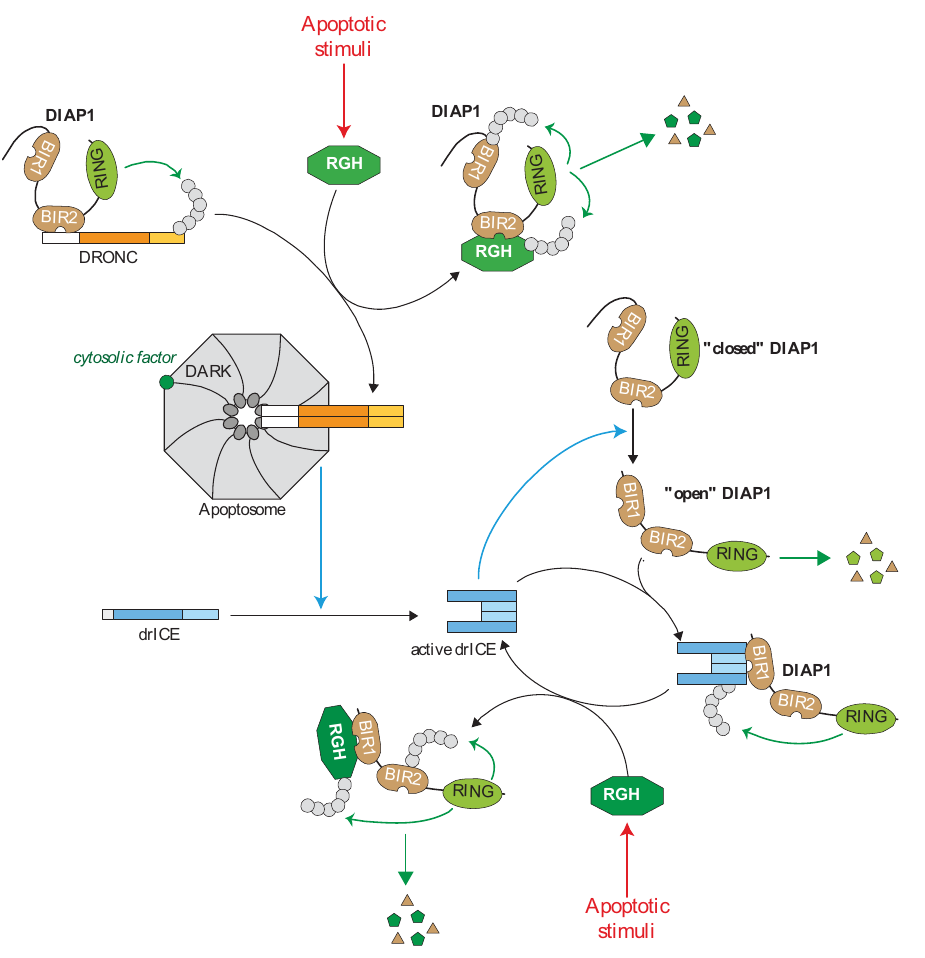
Interleukin-1-converting enzyme/Ced-3 related protease (drICE). DIAP1 inhibits